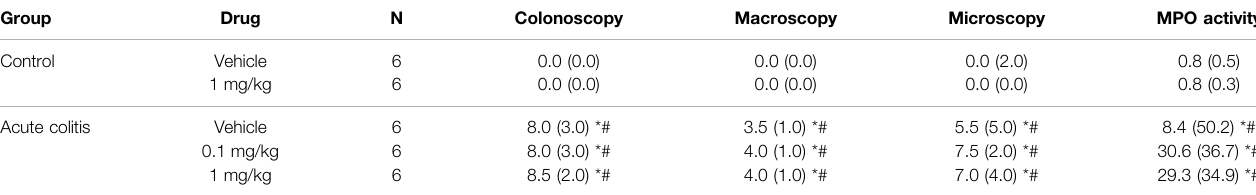
TABLE 2 | In fl ammatory parameters of all animals included in the acute TNBS colitis + UAMC-00050 experiment. Group